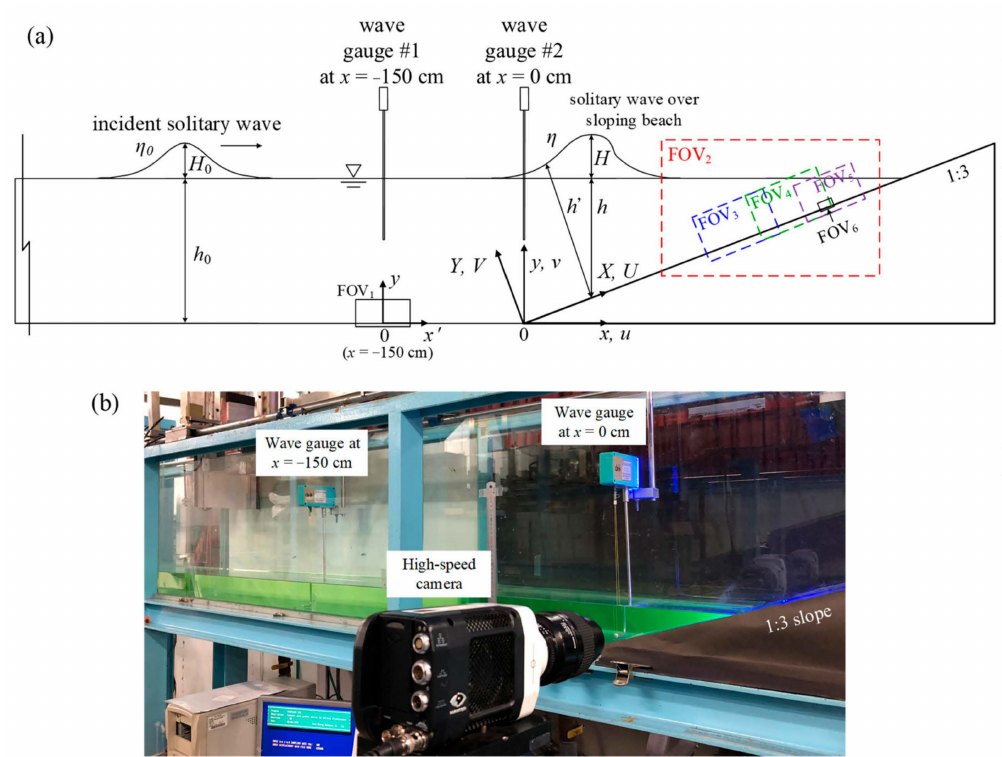
Figure 1. ( a ) Schematic diagrams indicating sloping beach model and two coordinate systems, together with deployment of two wave gauges and six fields of view, FOV 1 –FOV 6 , for HSPIV measurements; and ( b ) photo showing wave flume, high-speed digital camera, and part of sloping